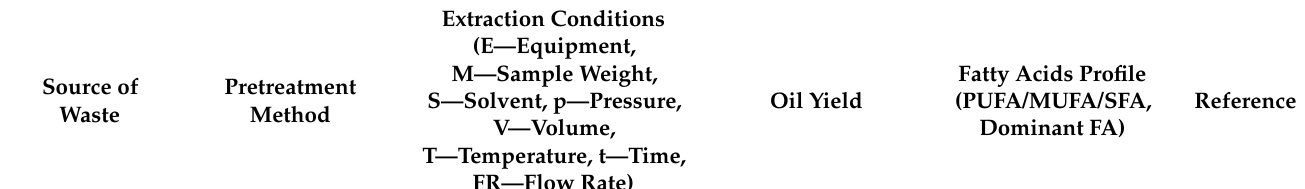
Table 9. Conditions and results of supercritical fluid extraction of oils and bioactive compounds from berry